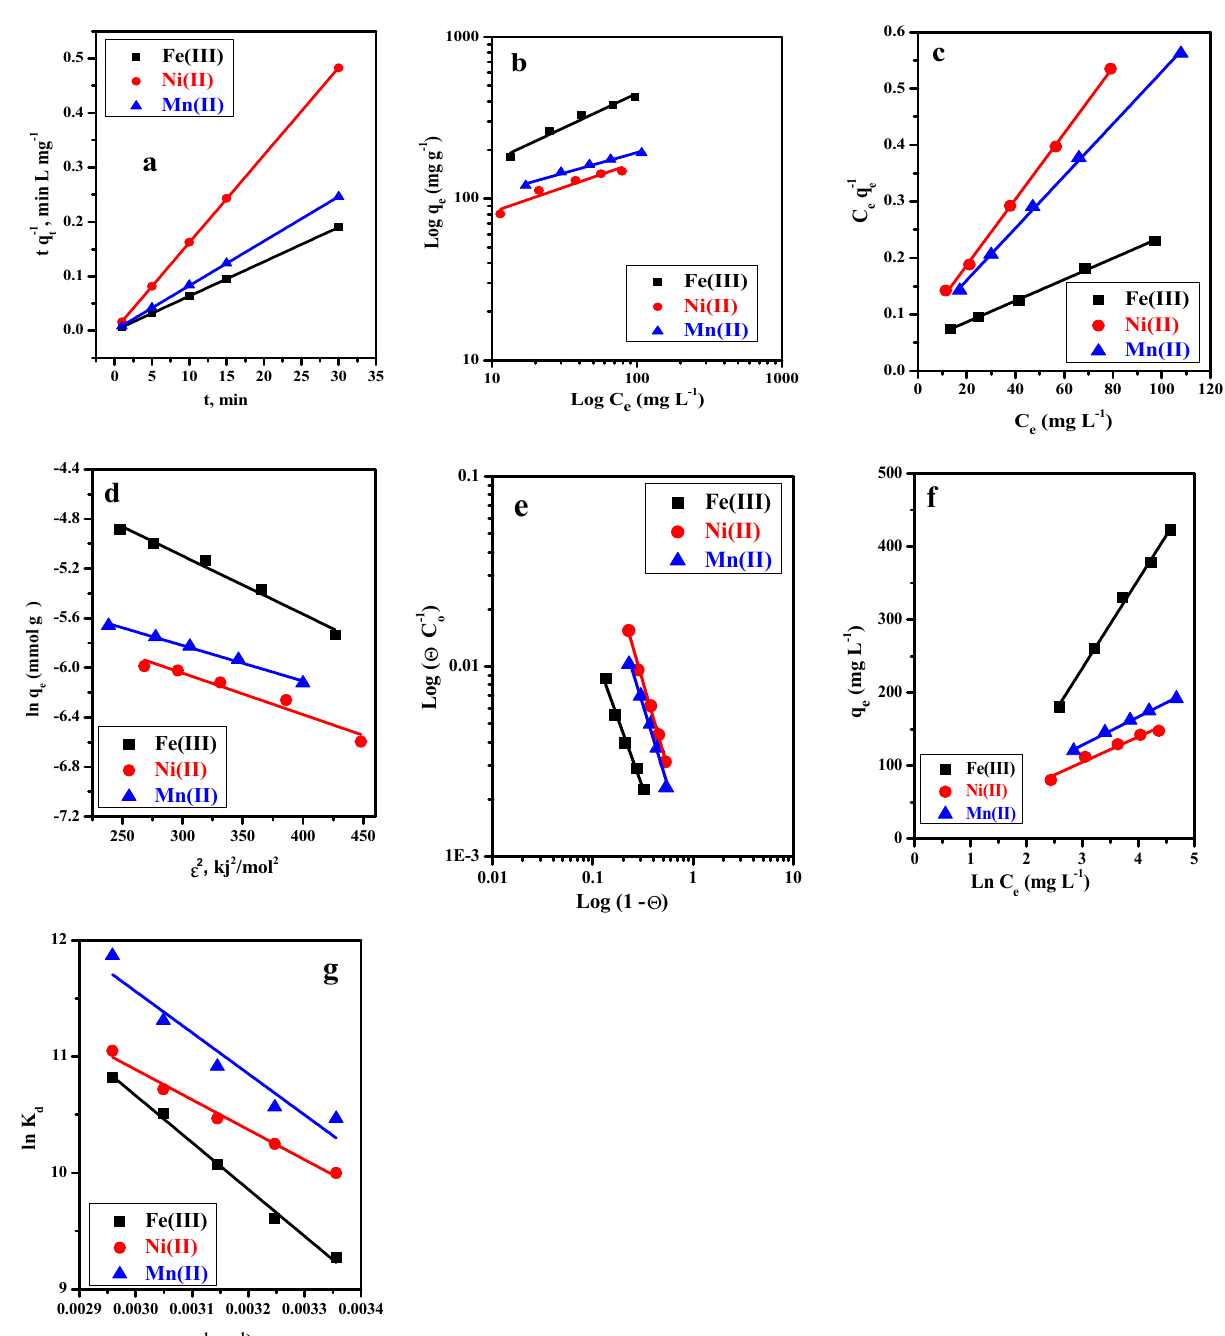
Figure 5. ( a ) Pseudo second-order plots, for the adsorption of Fe 3+ ([Fe] = 100 mg/L, pH = 2), Ni 2+ ([Ni] = 50 mg/L, pH = 5) and Mn 2+ ([Mn] = 100 mg/L, pH = 5) from aqueous media, V/m = 2.1 L/g, T = 25 °C using the modified (GO-C), ( b ) linear Freundlich isotherm plots, ( c ) linear Langmuir isotherm plots, ( d ) linear D-R isotherm plots. ( e ) Linear Flory–Huggins isotherm plots, ( f ) linear Temkin isotherm plots for the sorption of Fe 3+ (pH = 2.5), Ni 2+ (pH = 8) and Mn 2+ (pH = 7) from aqueous media, V/m = 2.1 L/g, T = 25 °C using the modified (GO-C) after 1.0 min and ( g ) Thermodynamic parameters for the adsorption of Fe 3+ ([Fe] = 300 mg/L, pH = 2.5, V/m = 0.83 L/g), Ni 2+ ([Ni] = 100 mg/L, pH = 8, V/m = 1.04 L/g) and Mn 2+ ([Mn] = 100 mg/L, pH = 7, V/m = 1.04 L/g) from aqueous media, after 1.0